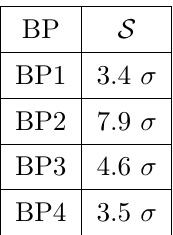
Table 3 . Signal and background e(cid:14)ciencies after applying various cuts for case I at 14 TeV. The cross-sections are calculated at NLO.